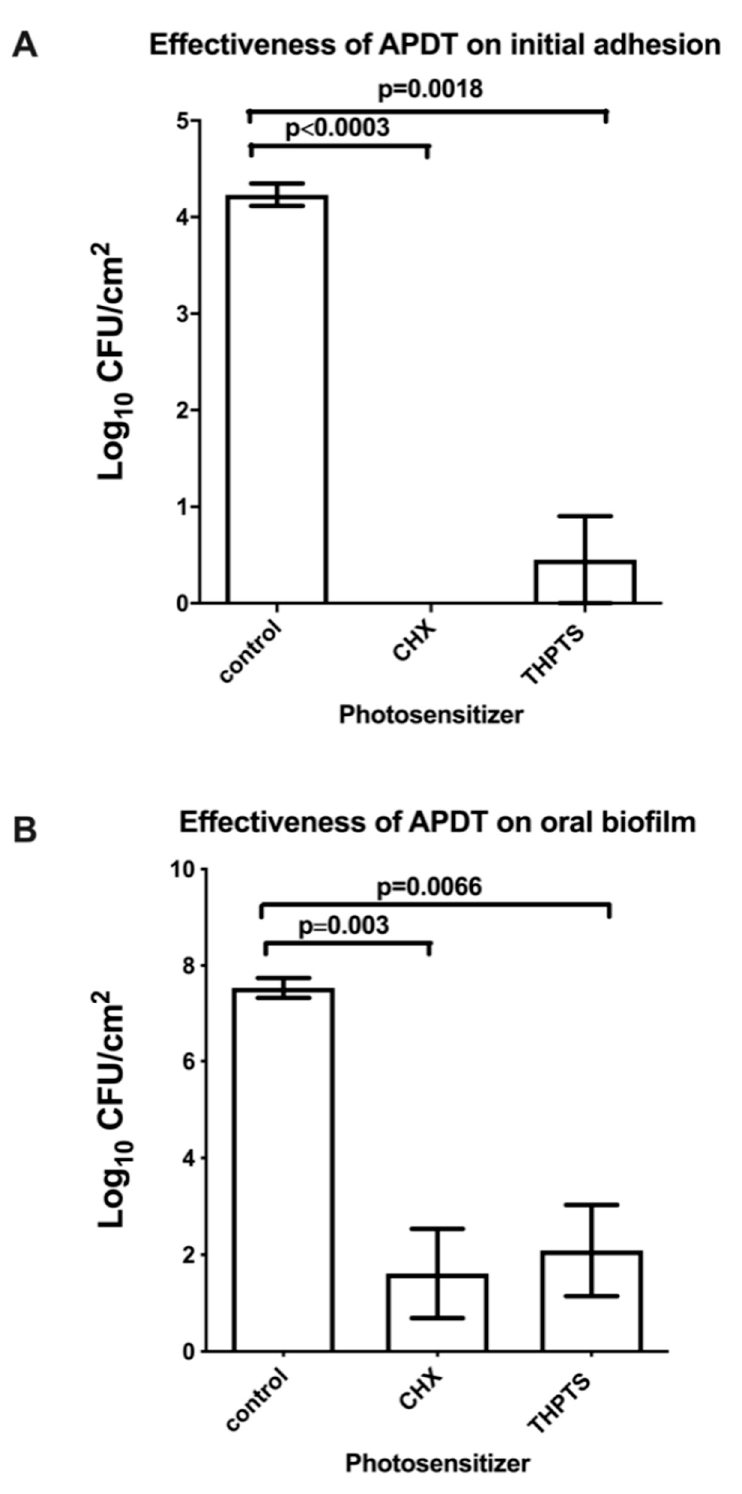
Figure 3. Columns depicting the colony forming units (CFUs) of oral bacteria after the antimicro- bial photodynamic therapy (aPDT), during a two-hour initial adhesion ( A ) and three-day biofilm formation ( B ), respectively. Tetrahydroporphyrin-tetratosylate (THPTS) served as a photosensitizer. Untreated and 0.2% chlorhexidine-treated (CHX) samples were also tested as negative and positive controls, respectively. The CFUs are shown on a log10 scale per square centimeter (Log10/cm 2 ). The significant p -values ( t -test) are noted on the graphs.